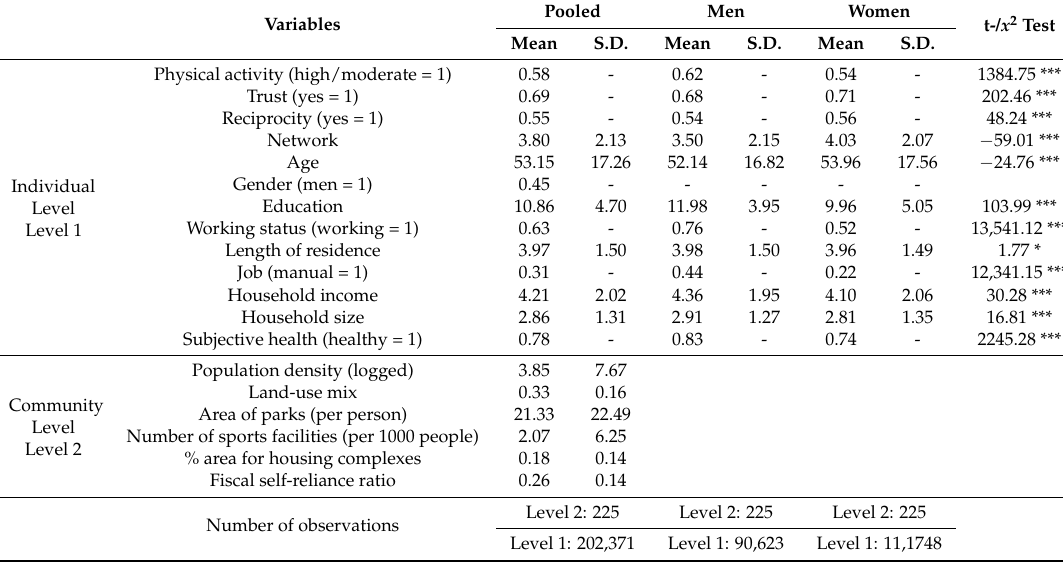
Table 1. Descriptive